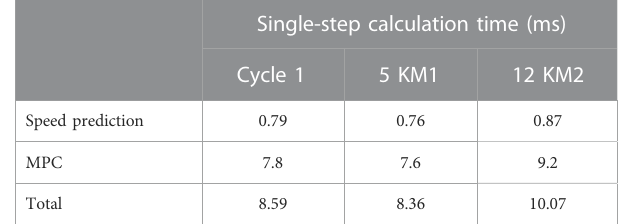
TABLE 7 Computational ef fi